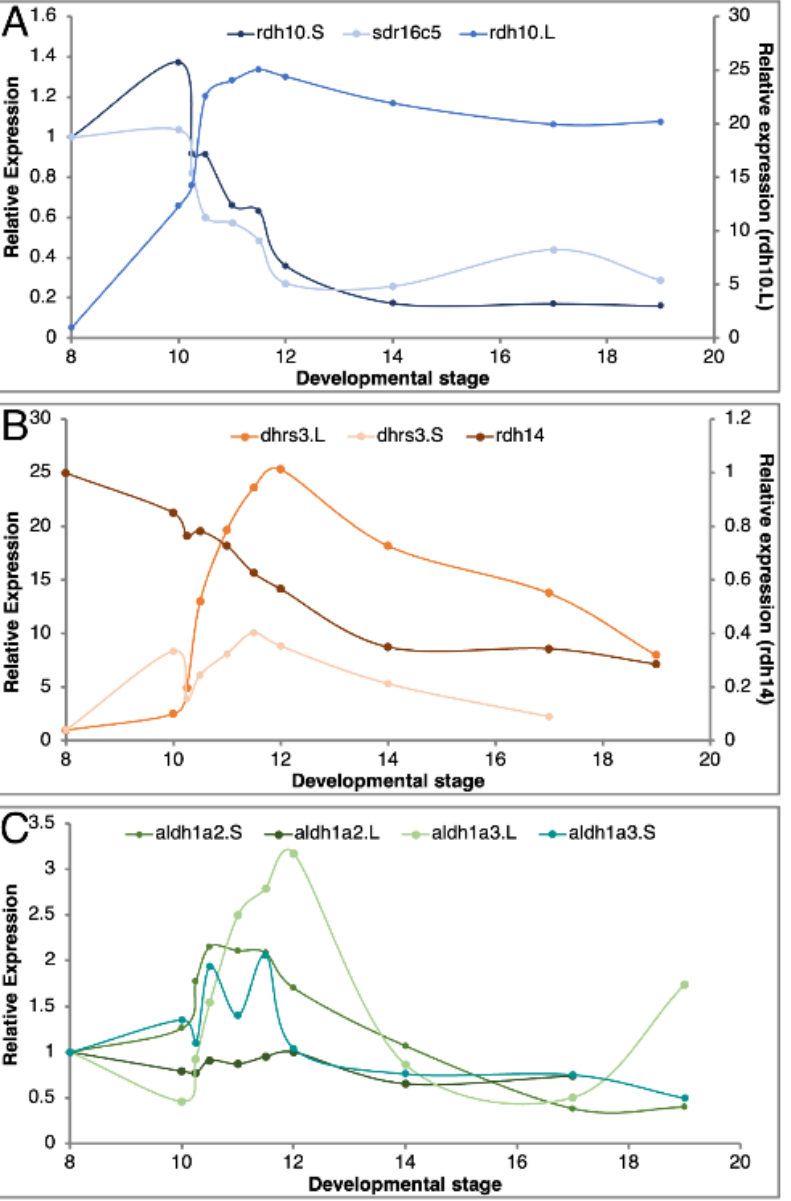
Figure 4. Comparative temporal expression pattern of homoeologs and singletons. Embryos were collected at different developmental stages from blastula to mid-neurula. The temporal expression pattern of each gene was determined by qPCR. ( A ) Expression of the rdh10 .L, rdh10 .S, and sdr16c5 .L genes (Producers 1). ( B ) Temporal expression pattern of dhrs3 .L, dhrs3 .S, and rdh14 .L (Suppressors). ( C ) Expression pattern of aldh1a2 .L, aldh1a2 .S, aldh1a3 .L, and aldh1a3 .S (Producers